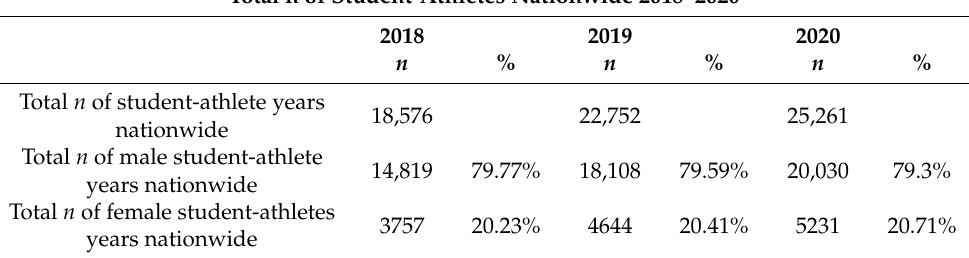
Table 3. 2018–2020 student athlete-years, showing a consistent proportion of male and female student